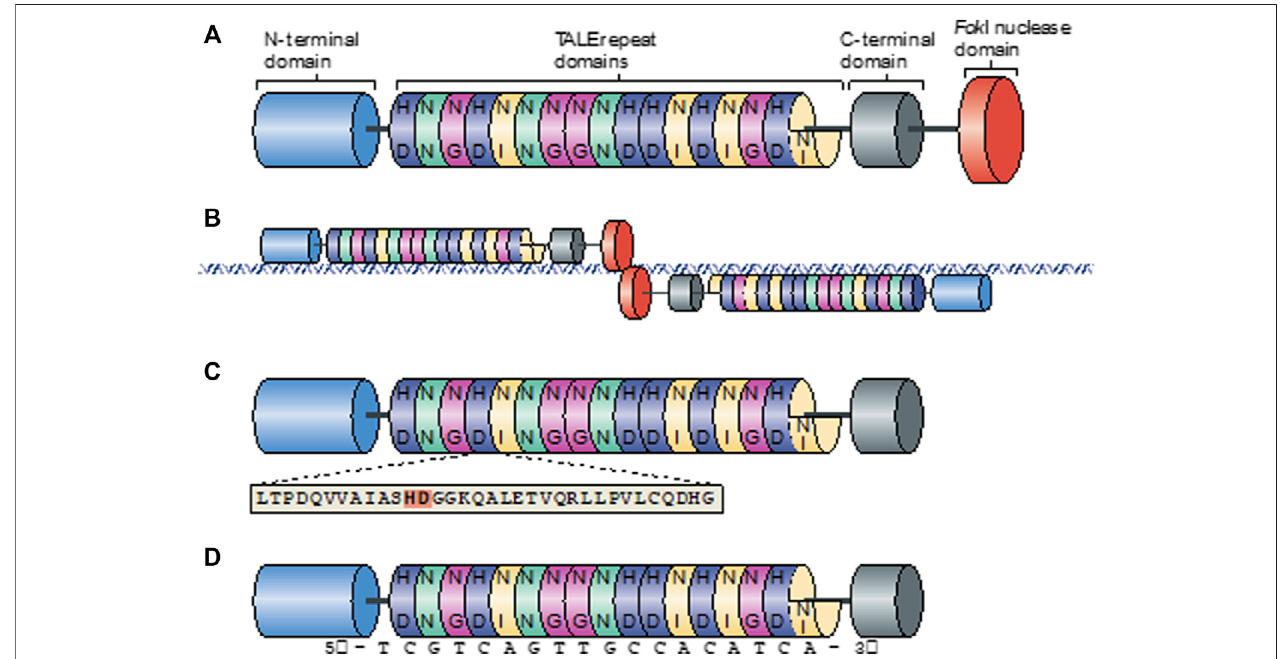
FIGURE2| OverviewoftheTALENstructure(JoungandSander,2013). (A) SchematicviewoftheTALENstructure.Coloreddiscswithtwolettersinsiderepresent the RVD. (B) Schematic view of TALEN pair binding to target site. Cleave of Fokl occurs on the spacer domain on the target site. (C) Schematic diagram of the TALEN binding domain with an amino acid sequence. Two amino acids that represent RVD are shown in bold. (D) Amino acid sequence of a TALEN binding domain with a nucleotide representation of each